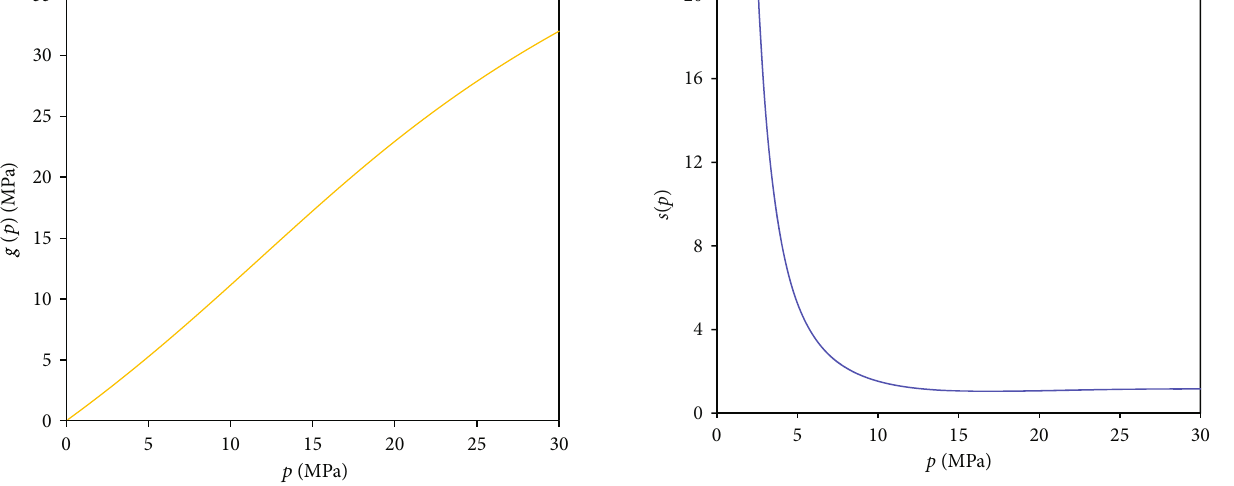
Figure 2: The relation curve of g ð p Þ vs. p for the normal pressure cases.